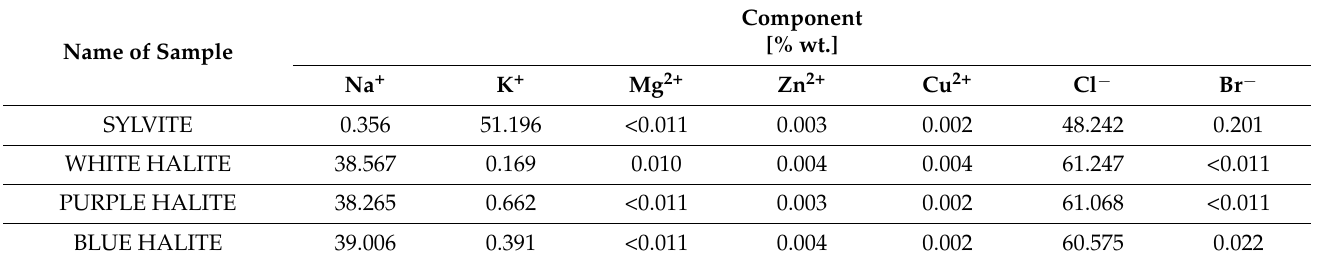
Table 2. Chemical analysis of the studied